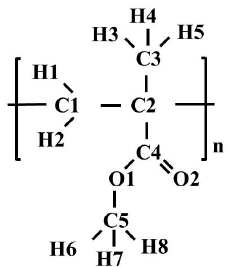
Figure 1. A monomer unit with designations of atoms. Table 1. Energy parameters and partial atomic charges for used potential model of poly (methyl methacrylate) (PMMA).